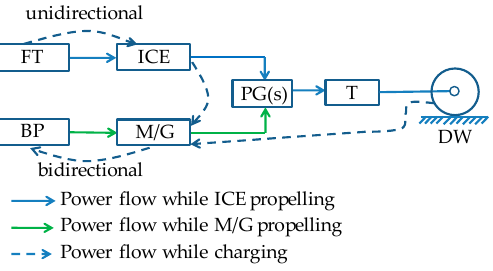
Figure 5. Conceptual illustration of the planetary hybrid powertrain system (PHPS).